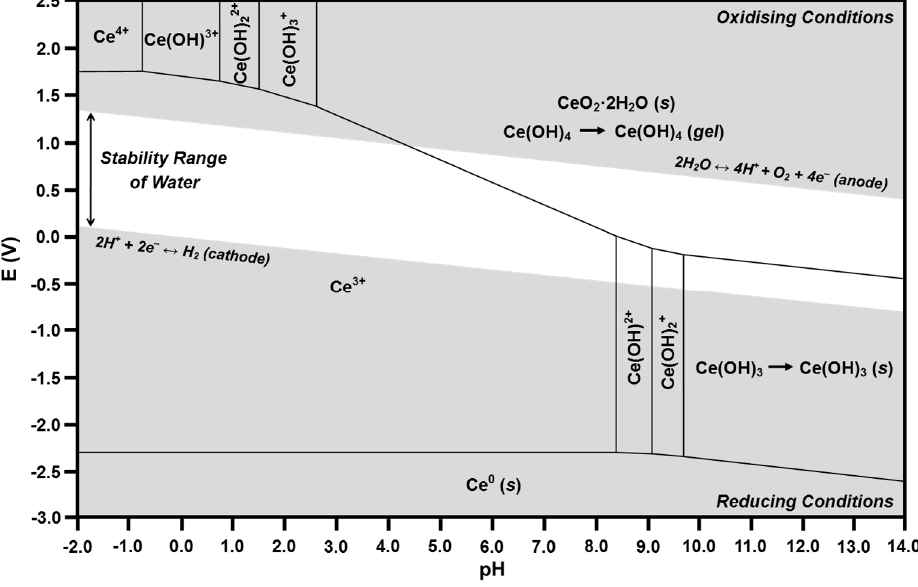
Figure 8. Calculated Pourbaix diagram for Ce-H 2 O.